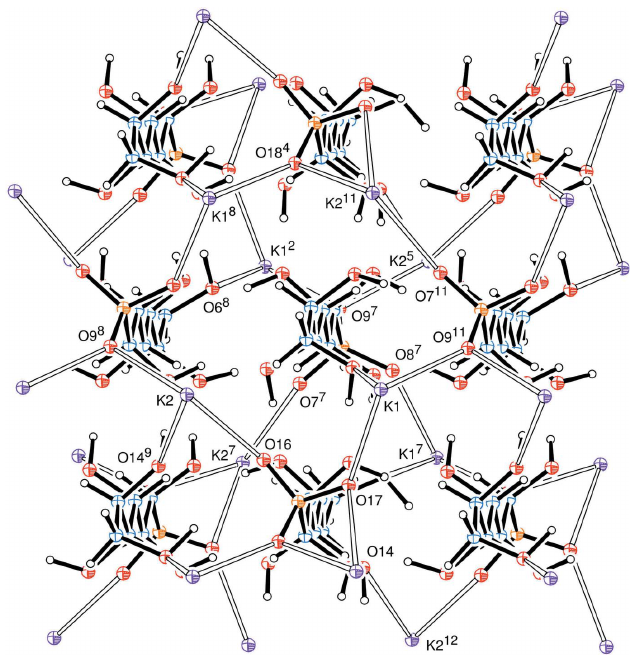
Figure 4 View looking along the all- trans sugar chain and neighbouring chains in the d -mannose–potassium bisulfite adduct; adjacent chains point in opposing directions. Atom coordinates were taken from the CCDC deposition, code 172060 (Cole et al. , 2001). Atoms are represented by small spheres of arbitrary radii. Symmetry codes: (2) 1 (cid:3) x , 1